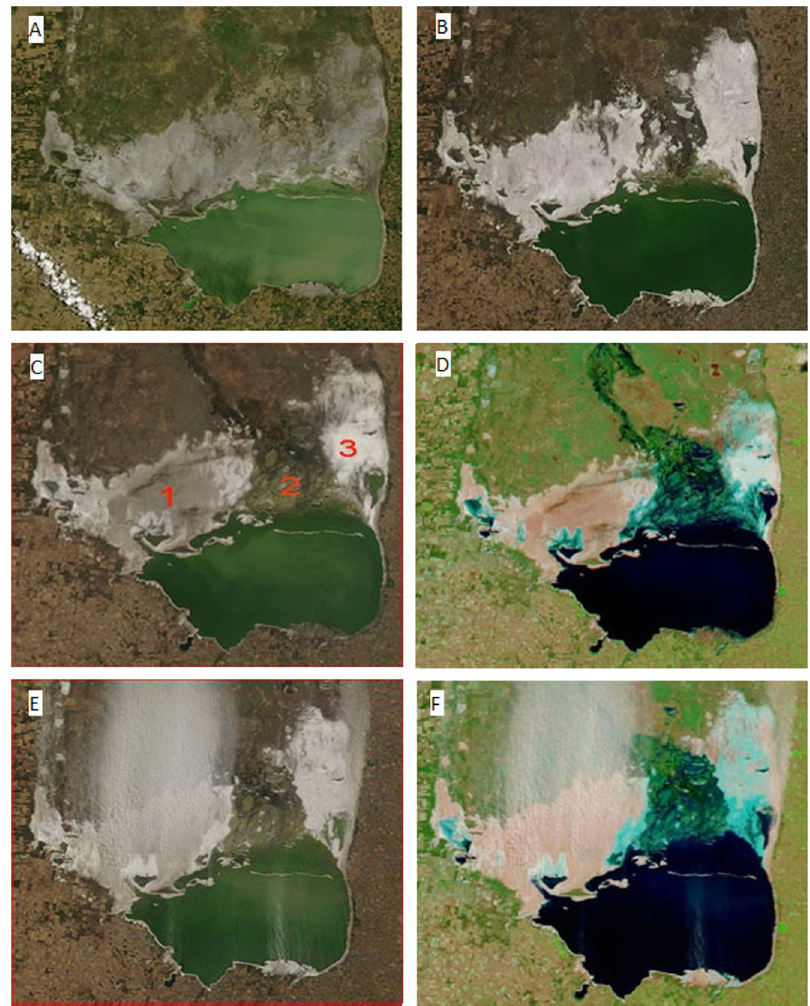
Fig 8. Stages in Mar Chiquita mudflat playas according to emission condition. A: gray; B: white; C: mosaic of surface patterns under dry conditions cold conditions: 1) Gray, 2) Striped brown (wetlands of the Dulce River delta); 3) Bright white; D: same image, 721 bands; E: and F: same as in C and D, eight days later. Notice the intense salt dust emission from the gray surfaces. MODIS images (AERONET_Cordoba-CETT), 250 m resolution, true color (unless 721 bands are indicated): A: January 21, 2014 (terra); B: June 25, 2013 (terra); C: July 16, 2012 (aqua); D: July 16, 2012, 721 bands (terra); E: July 24, 2012 (terra), F: July 24, 2012, 721 bands